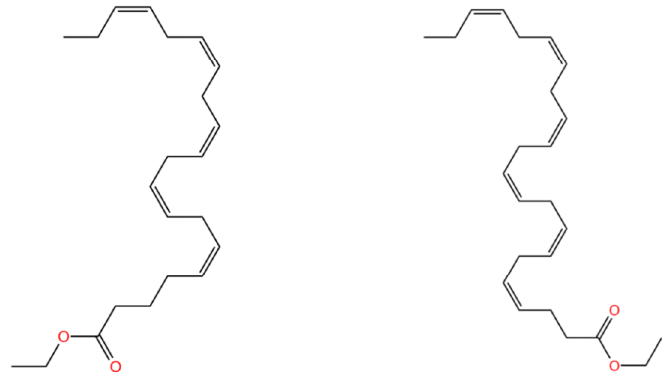
Figure 2. The chemical structural formula of EPA-EE ( left ) and DHA-EE ( right ).